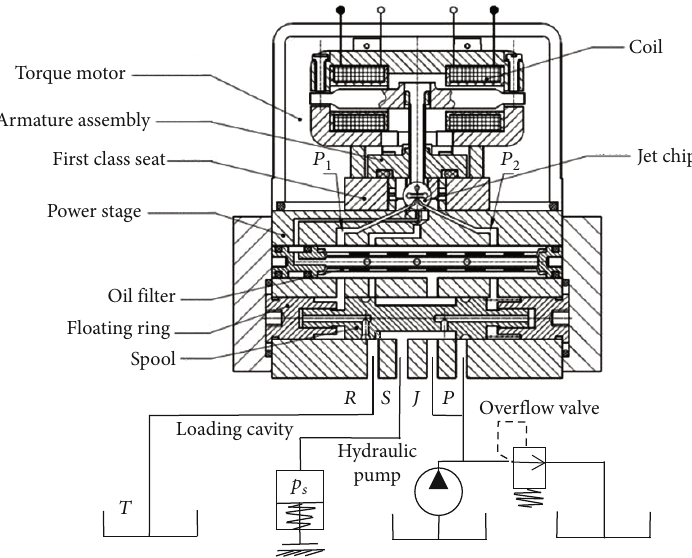
Figure 1: The structure of the de fl ector jet pressure servo